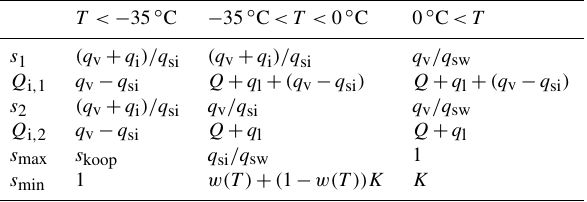
Table 1. The parameters involved in the cloud cover scheme, Eqs. (1) and (4). The rows show different parameters as a function of the temperature regime T . We discuss two different choices for s and Q i in the text, s 1 /Q i , 1 and s 2 / Q i , 2 . We use a linear weighting function w(T ) = (T − 273 . 15 )/( 238 . 15 − 273 . 15 ) for T in